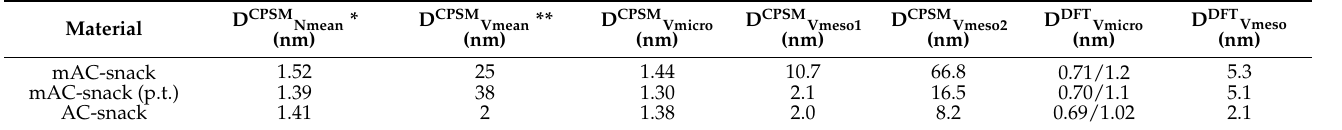
Table 2. Textural parameters derived from CPSM simulation of N 2 adsorption-desorption overall hysteresis loop and from the DFT method